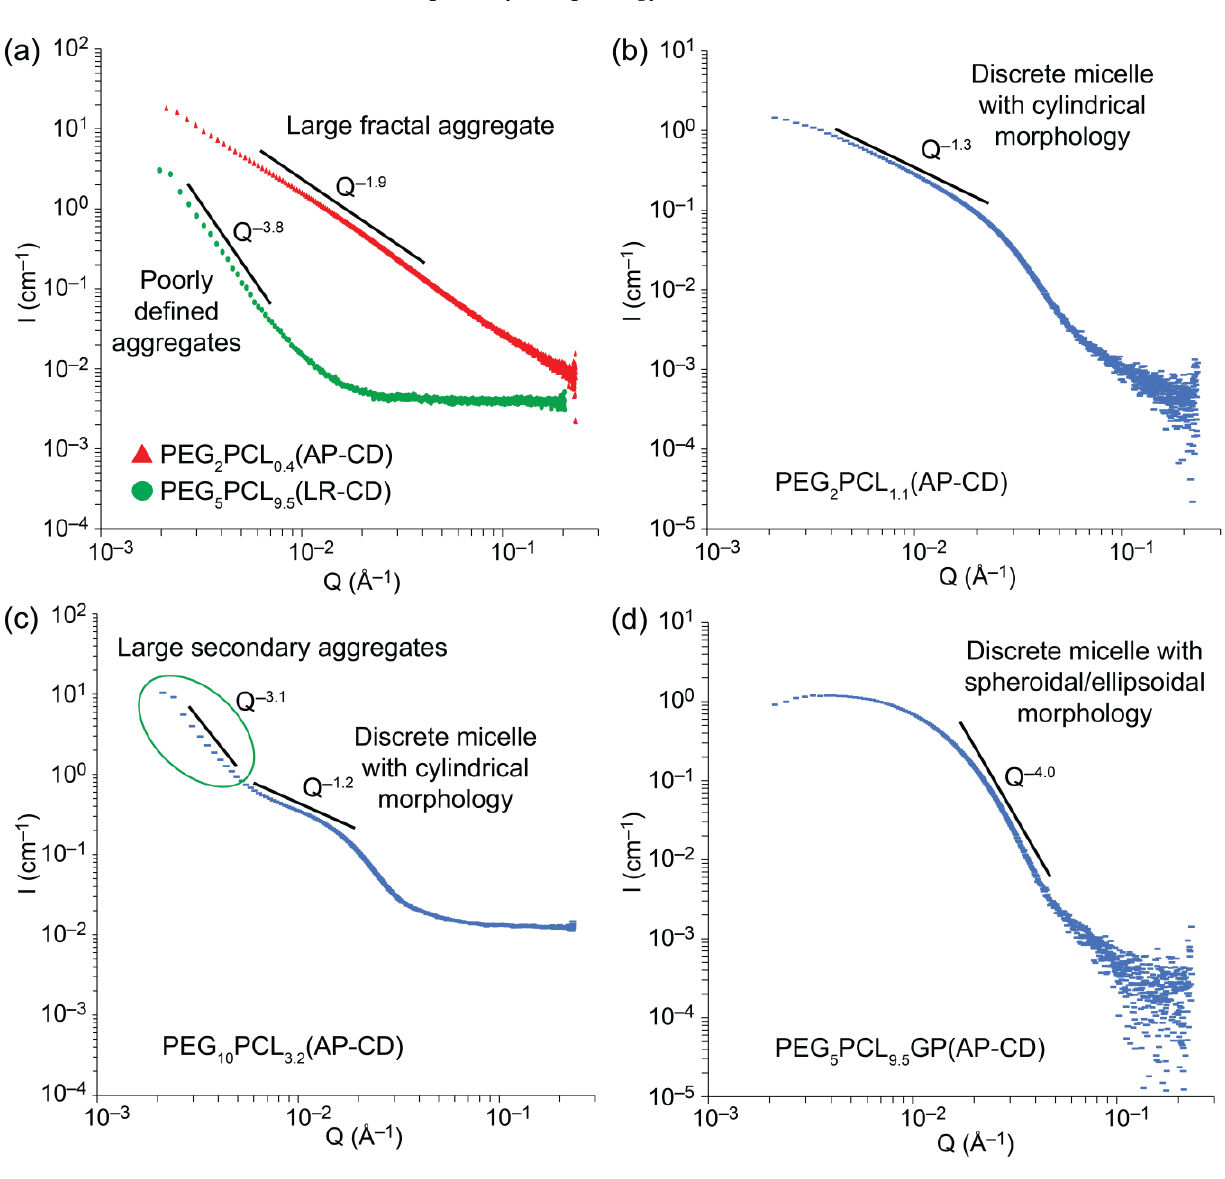
Figure 3. Representative SAXS scattering profiles complete with power laws to indicate the morphology of the aggregates or micelles: ( a ) PEG 2 PCL 0.4 (red profile), ( b ) PEG 2 PCL 1.1, and ( c ) PEG 10 PCL 3.2 as prepared in the absence of β-CD, ( a ) PEG 5 PCL 9.5 (green profile) following lyophilization/reconstitution in the absence of β-CD, and ( d ) gossypol-loaded PEG 5 PCL 9.5 as prepared in the absence of β-CD.